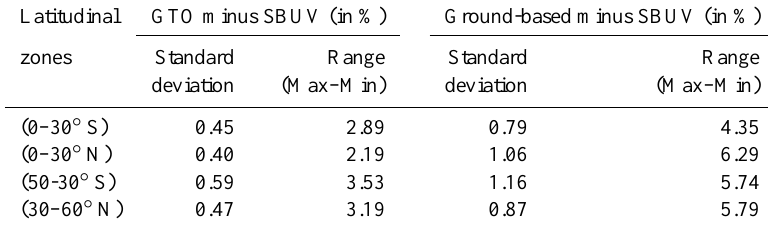
Table 5. Summary of the differences in monthly zonal mean anomaly (four broad latitudinal zones).